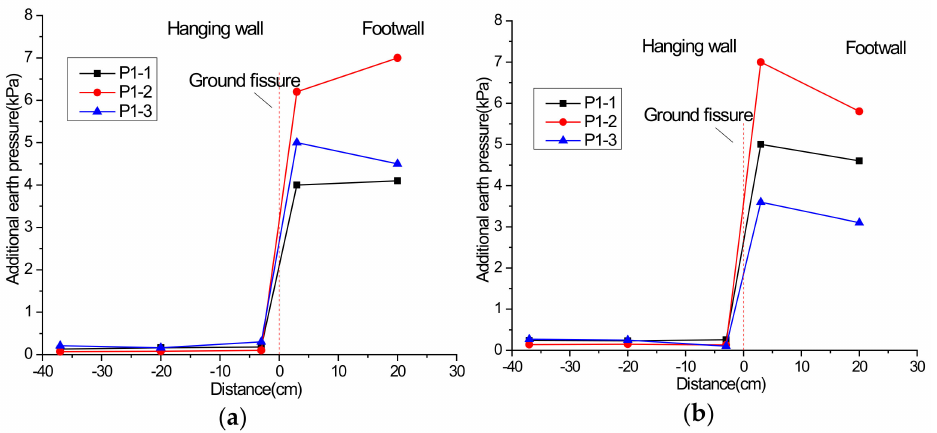
Figure 19. Additional earth pressure at 15 cm height under the scenario of hanging wall descending